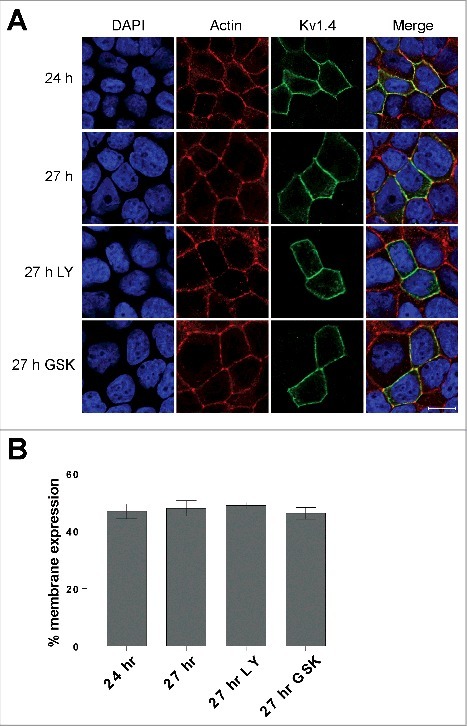
Inhibition of PI3K and SGK1 kinases do not affect Kv1.4 localization in polarized MDCK cells. (A) MDCK cells transiently expressing Kv1.4 were subjected to a calcium switch assay for 24 hr and following treated with inhibitors of either PI3K (10 µM LY-294.002) or SGK1 (1 µM GSK-650394) for 3 hr before fixation. Scalebar, 10 µm. (B) Quantification of Kv1.4 signals from (A). The Kv1.4 fluorescent cell surface Kv1.4 signal is expressed as a percentage of fluorescent Kv1.4 total cell signals. All groups were compared to the signal at 24 hr. Quantification was performed as described in the Materials and Methods section. 6 ≤ n ≤ 10 for each group. Bars represent means of each group ± SEM.